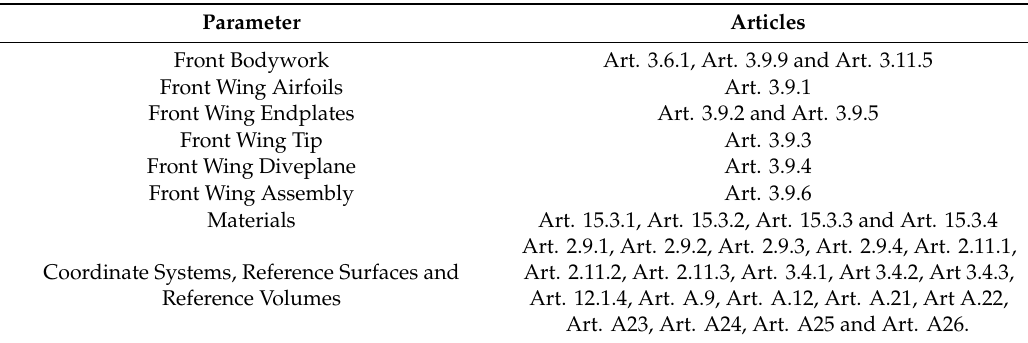
Table 1. 2022 FIA Formula One Technical Regulations